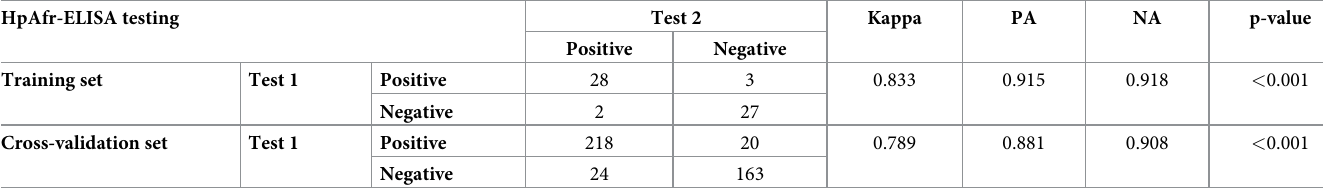
Table 1. Qualitative agreement of HpAfr-ELISA outcomes at two repeated testing. HpAfr-ELISA testing